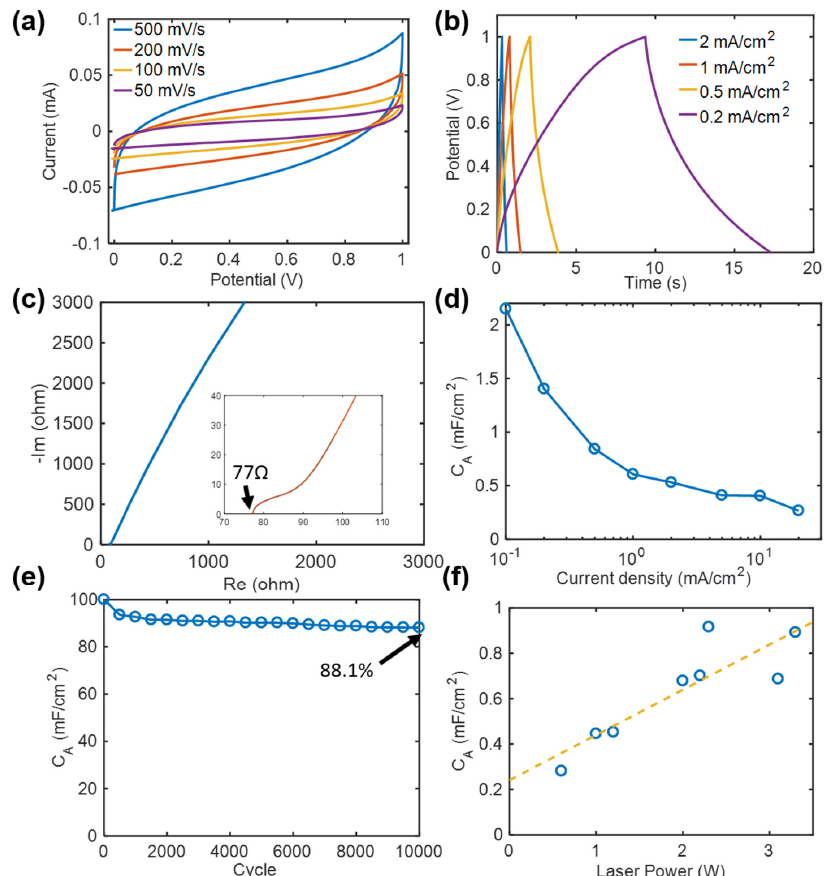
Figure 7. Electrochemical characteristics measured in a two-electrode configuration: ( a ) cyclic voltammetry (CV) curves of laser-pyrolyzed microsupercapacitor electrode (laser power: 2.2 W), ( b ) galvanostatic charge-discharge (CC) curves of laser-pyrolyzed microsupercapacitor electrode, ( c ) electrochemical impedance spectroscopy (EIS) curve of the microsupercapacitor (inset: EIS curve near the x-intercept), ( d ) C A of the microsupercapacitor calculated from the CC curves at various current densities, ( e ) cyclic charging / discharging stability of the microsupercapacitor at 2 mA / cm 2 , and ( f ) C A of microsupercapacitor electrodes fabricated at various laser